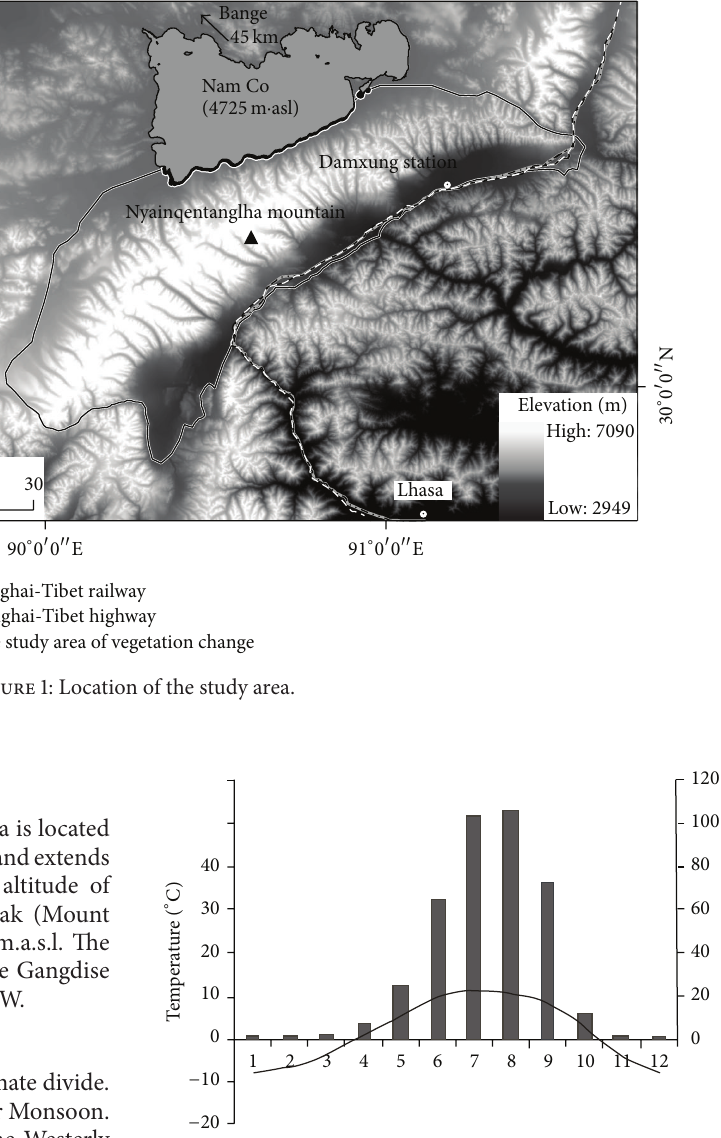
Figure 2: Monthly climatologies of air temperature (1962–2008, curve) and precipitation (1962–2008, columns) for three meteoro- logical stations (Damxung, Bange, and Lhasa). The mean altitude of three meteorological stations is 4500